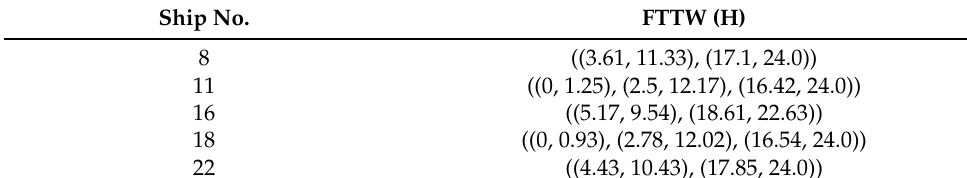
Table 4. Feasible tidal time windows for tide-dependent vessels.